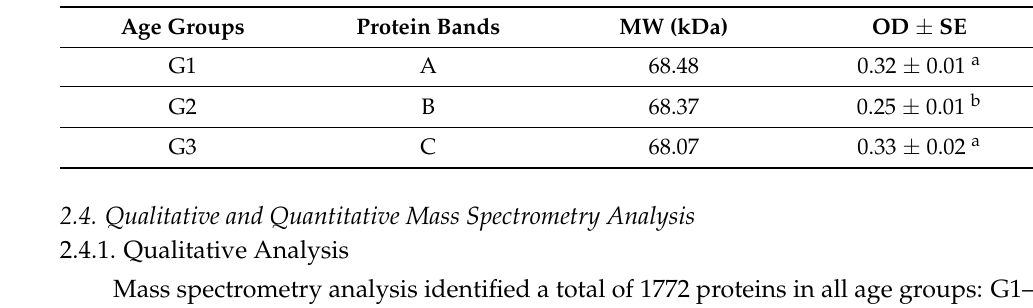
Table 2. Average optical density (OD) values (mean ± SE) of differentially expressed proteins (DEPs) of the cauda epididymal spermatozoa of dogs ( Canis lupus familiaris ) in different age groups (G1: 12–41 months old; G2: 42–77 months old; G3: 78–132 months old). Different superscripts (a, b) within the same column indicate significant differences ( p ≤ 0.05) among the fractions. DEPs are marked with letters from A to C. MW—average molecular weight.